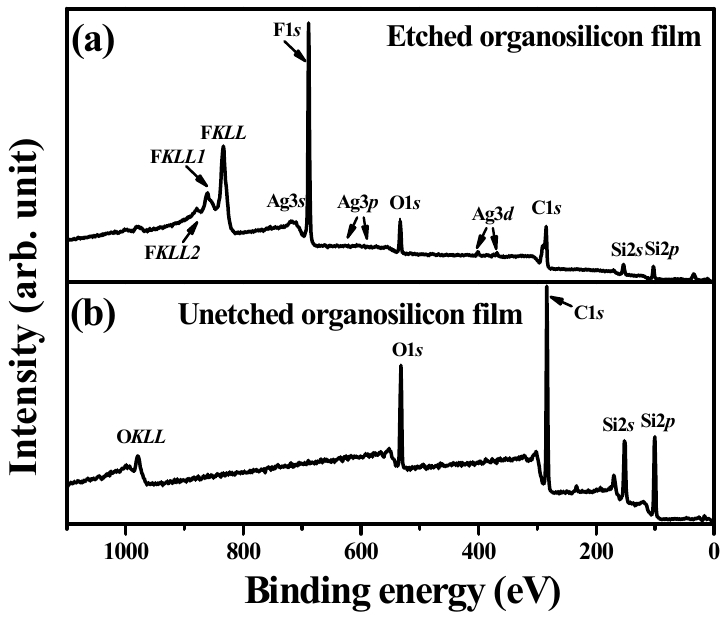
Figure 11. XPS survey spectra taken on the surface of the organosilicon film ( a ) with and ( b ) without the CF 4 plasma etching.